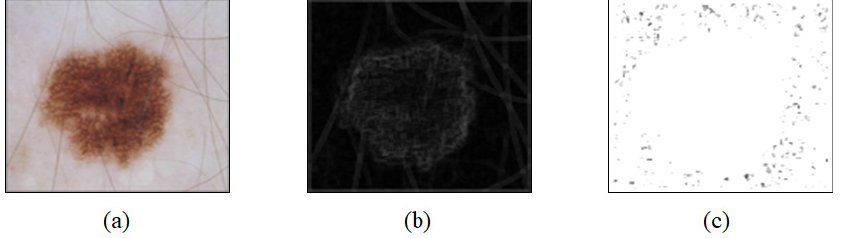
Figure 9. Examples of the image obtained based on dermoscopy and a feature map according to the dermoscopy image. ( a ) Dermoscopy image and ( b , c ) feature maps. dermoscopy image. ( a ) Dermoscopy image and ( b , c ) feature